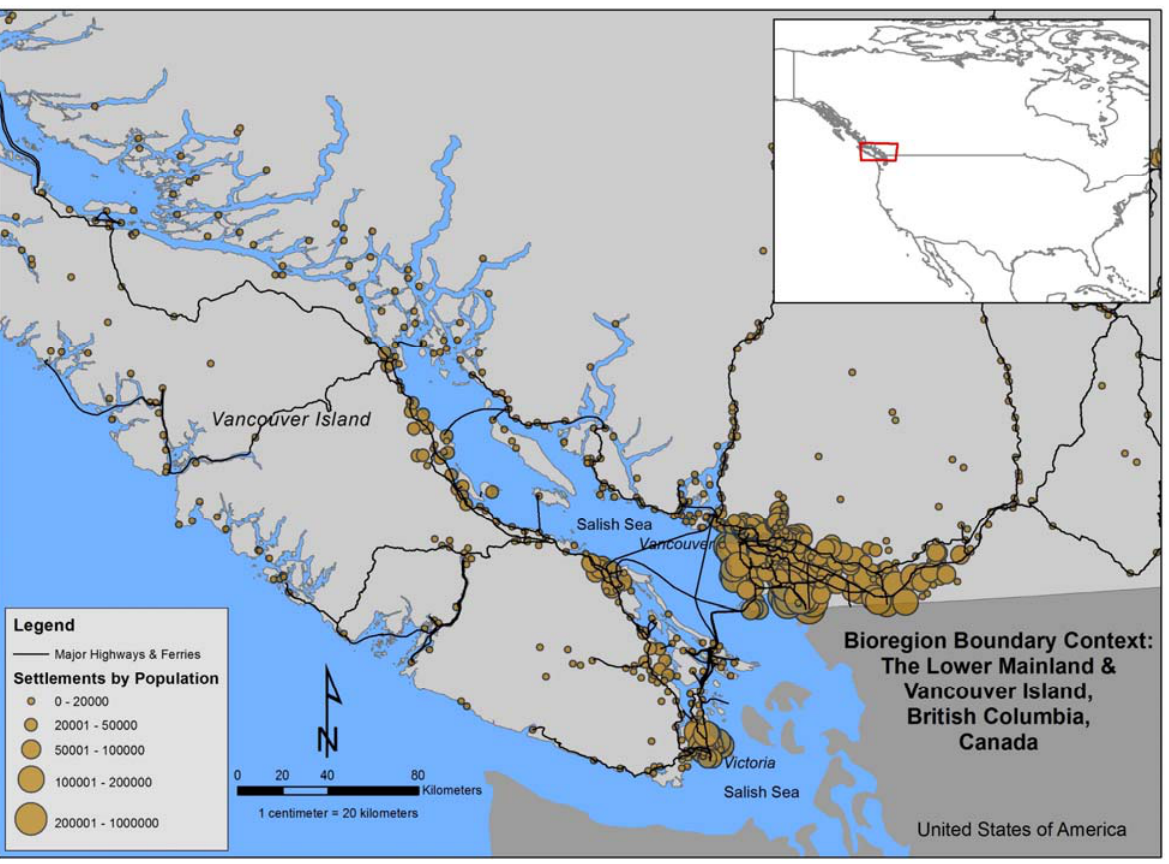
Figure 1. The Southwest British Columbia Context. The biogeographic region of SWBC showing major population centers and transport routes of the mainland in relation to the Canada-USA border, the Salish Sea and Vancouver